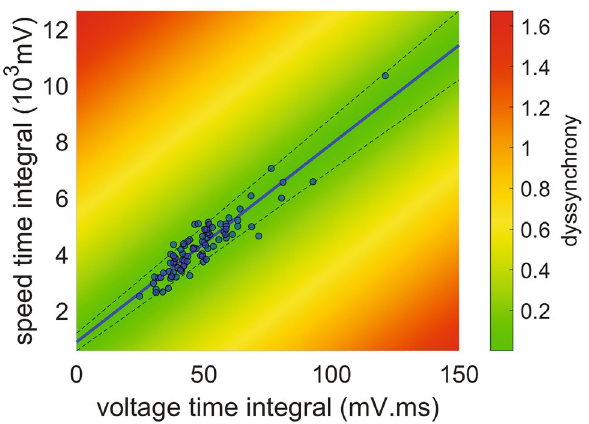
Figure 2. Heatmap showing the dyssynchrony index and the VCG-based time integral of voltage as well as speed from healthy individuals. Vector speed time integral (STI) plotted against vector voltage time integral (VTI) for 90 control individuals. The blue line is the linear fit of the data (r 2 = 0.86, dotted lines: 95% confidence interval). The line’s slope represents the tissue characteristic time (70.28 ms −1 ). The colour bar highlights